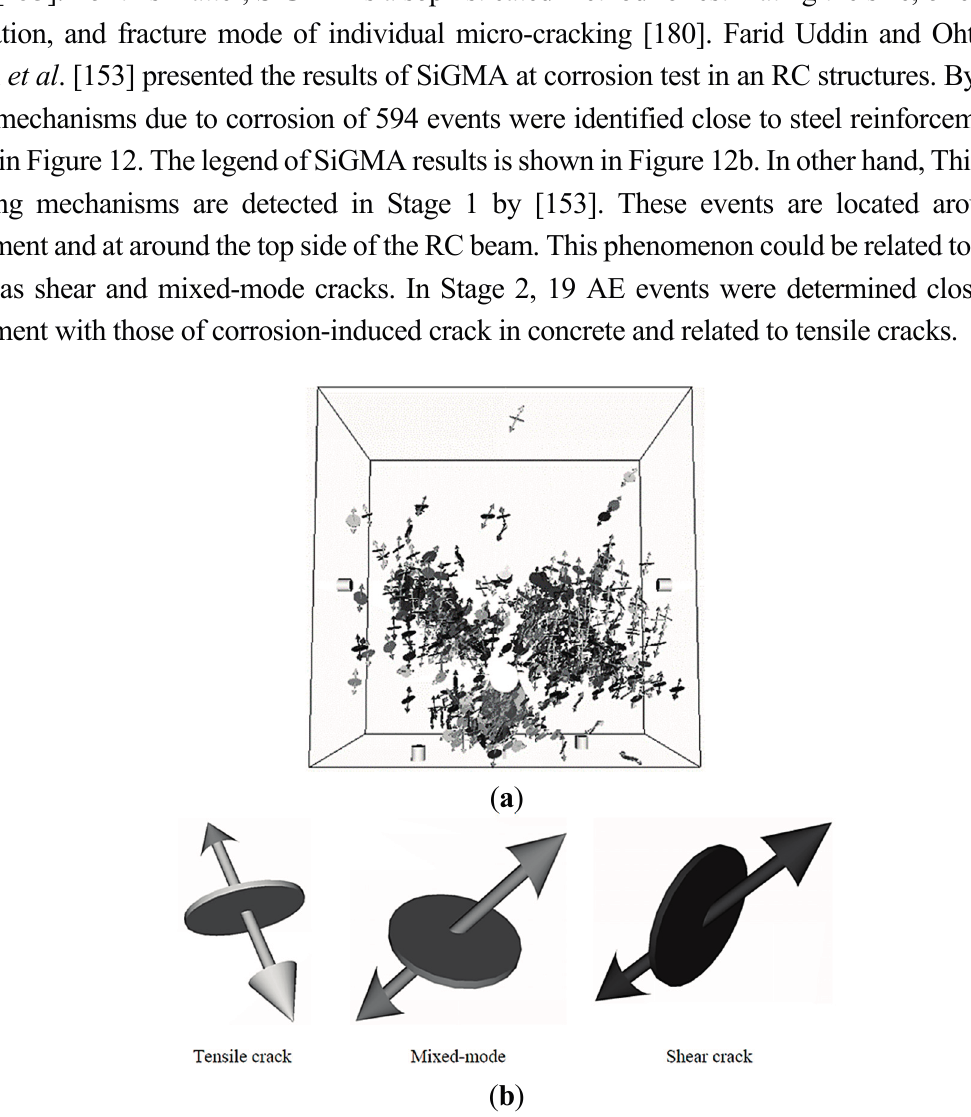
Figure 12. Results and models of SiGMA data ( a ) 594 events; and ( b ) models of tensile, mixed-mode, and shear crack (Reproduced and modified from